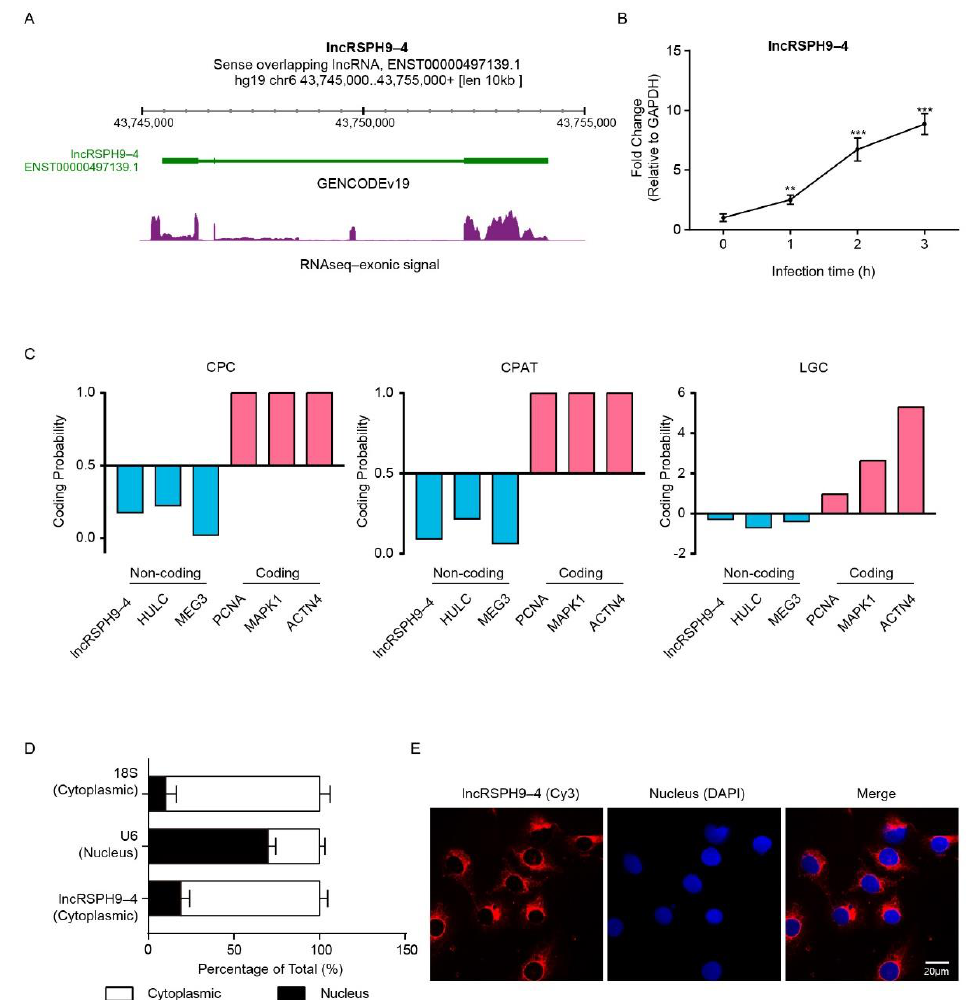
Figure 1. The expression and subcellular localization of lncRSPH9-4 . ( A ) Visualization of lncRSPH9-4 in ZENBU browser, which showed exonic expression signal in several different visualizations. ( B ) LncRSPH9-4 expression in hBMECs was measured using qPCR after meningitic E. coli infection for 0 h, 1 h, 2 h and 3 h. GAPDH was used as the reference control. ** indicated p < 0.01 and *** indicated p < 0.001 by one-way ANOVA analysis. ( C ) The prediction of lncRSPH9-4 coding potential by using CPC, CPAT and LGC. ( D ) Nuclear/Cytoplasmic localization analyses of lncRSPH9-4 in hBMECs by qPCR. The 18S and U6 distribution were selected as the cytoplasmic control and the nuclear control, respectively. ( E ) Subcellular localization of lncRSPH9-4 in hBMECs by FISH assay. Red, Cy3-labeled positive hybridization signals; Blue, DAPI- stained nucleus. Scale bars, 20 μm.